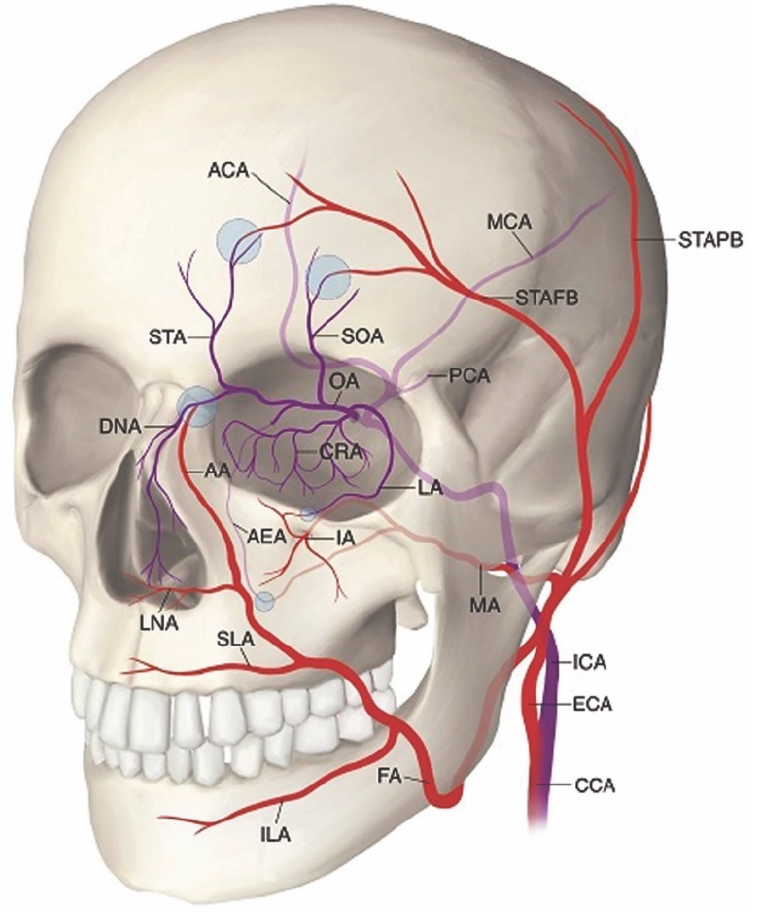
Figure 19. Schematic representation of the arterial vasculature of the head and neck comprised of the internal carotid (purple) and external carotid (red) main branches. The ophthalmic artery is a branch of the internal carotid artery and gives rise to terminal muco-cutaneous branches. These branches are involved in many of the anastomoses (blue circles) formed between the internal and external carotid arterial systems. AA, angular artery; ACA, anterior cerebral artery; AEA, anterior ethmoidal artery; CCA, common carotid artery; CRA, central retinal artery; DNA, dorsal nasal artery; ECA, external carotid artery; FA, facial artery; IA, infraorbital artery; ICA, internal carotid artery; ILA, inferior labial artery; LA, lacrimal artery; LNA, lateral nasal artery; MA, maxillary artery; MCA, middle cerebral artery; OA, ophthalmic artery; PCA, posterior cerebral artery; SLA, superior labial artery; SOA, supraorbital artery; STA, supratrochlear artery; STAFB, superficial temporal artery frontal branch; STAPB, superficial temporal artery parietal branch. From Wang et al. [26], with permission.